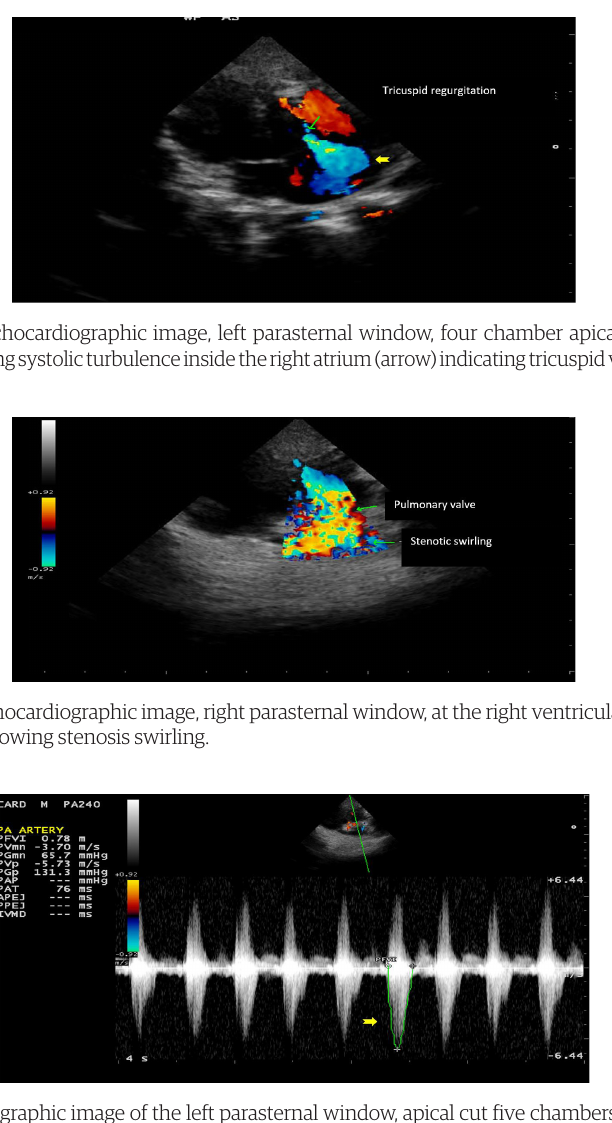
Figure 6. Echocardiographic image of the left parasternal window, apical cut five chambers, spectral Doppler showing pulmonary flow with a maximum velocity of 5.73 m [/s (arrow) and a pressure gradient of 131.1 mmHg, characterizing pulmonary stenosis.